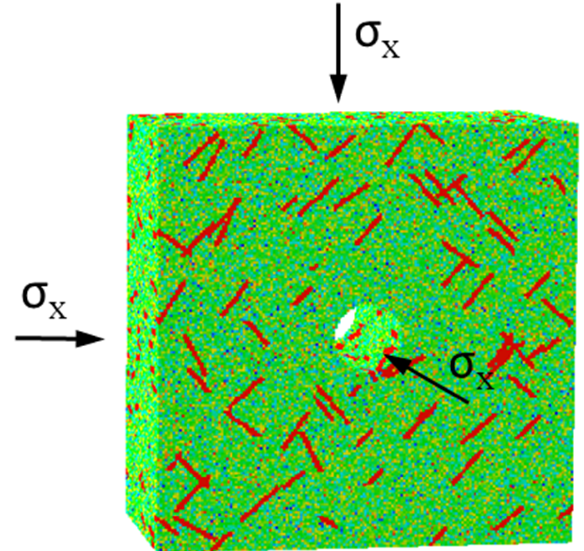
Figure 13. Random jointed surrounding rock numerical Model C and boundary conditions.